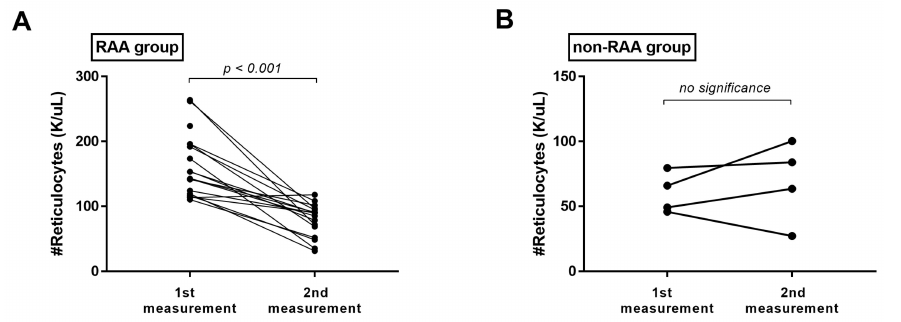
Figure 2. Changes in absolute reticulocyte count in ( A ) the RAA group and ( B ) the non-RAA group. RAA: reticulocytosis in absence of anemia.